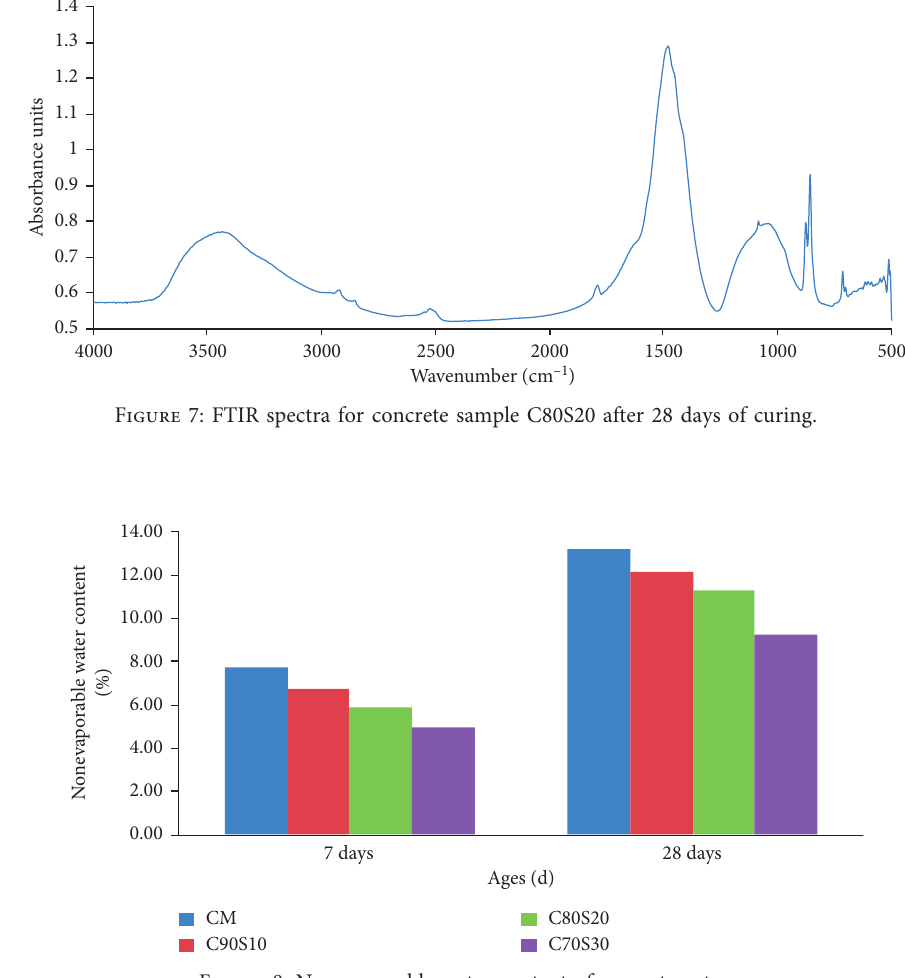
Figure 8: Nonevaporable water content of cement